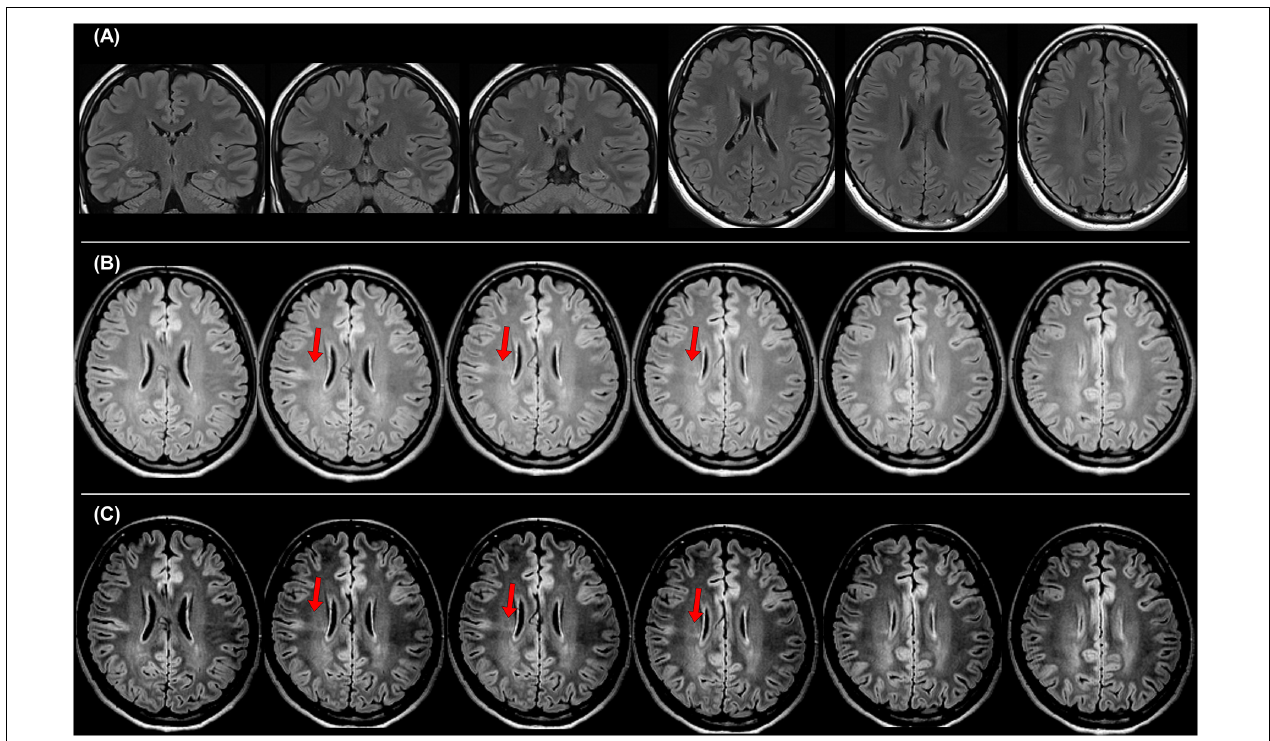
FIGURE 3 | A case with drug-resistant focal epilepsy, who benefited from the official standard protocol for epilepsy. It was impossible to detect any abnormalities in both coronal and axial 2D fluid-attenuated inversion recovery (FLAIR) images with 3-mm slice thickness (A) , but the 3D FLAIR images revealed findings of a bottom-of-sulcus-type focal cortical dysplasia with transmantle sign (B) , and changing the signal range is sometimes helpful to clearly visualize the lesion (C) . The pathological finding was focal cortical dysplasia type IIb.